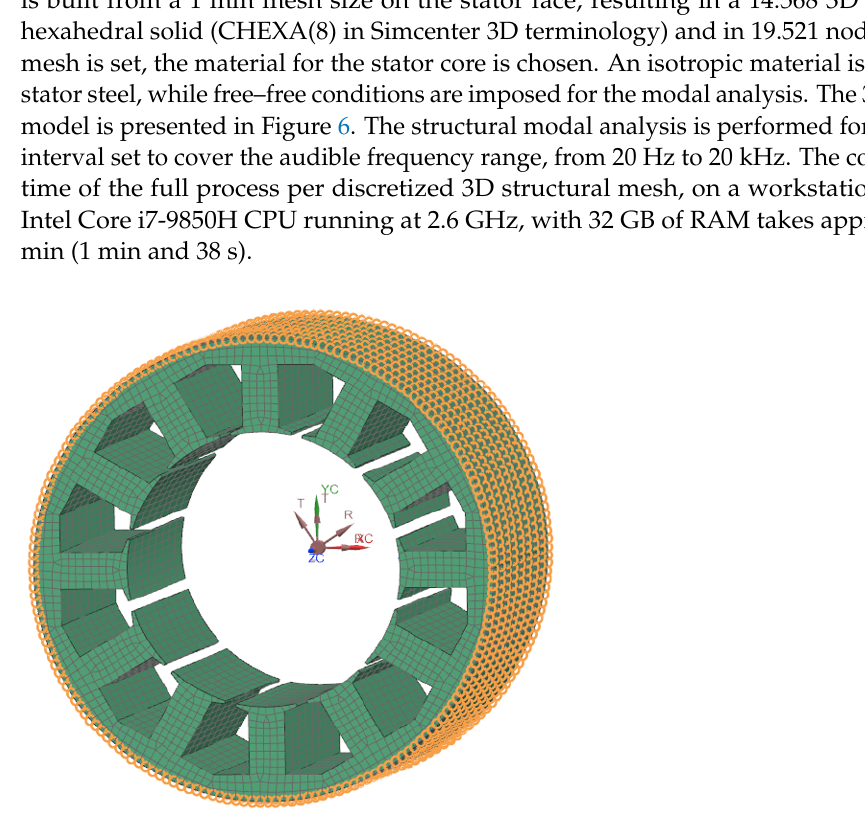
tion and n is the order of the longitudinal